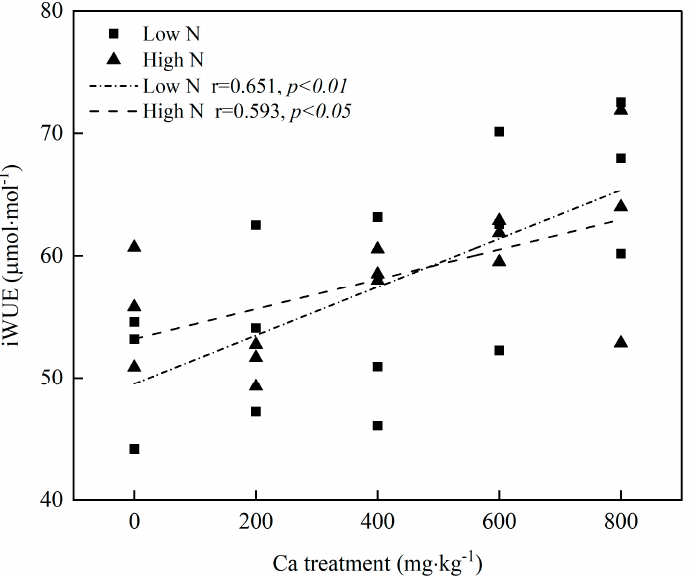
Figure 5. Effect of Ca treatments on the iWUE of shoots under different N levels.